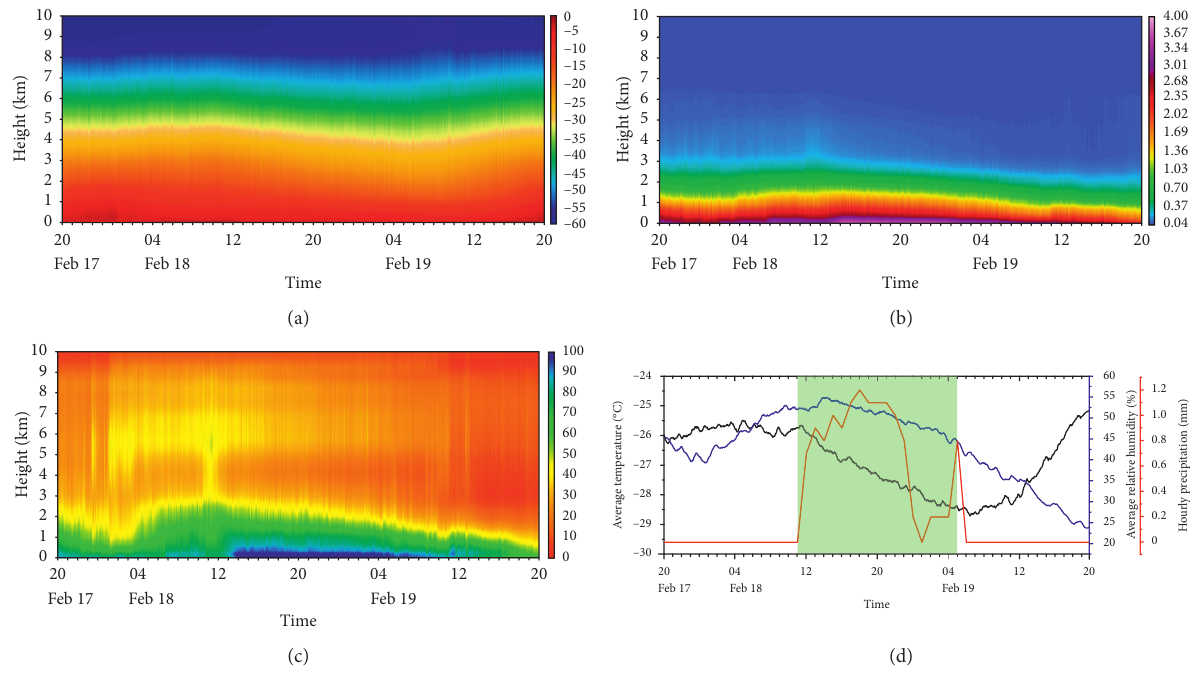
Figure 7: Time-height profile of ground-based microwave radiometer data: (a) temperature (shaded; unit, ° C), (b) water vapor density (shaded; unit, g kg − 1 ), (c) relative humidity (shaded; unit, %), and (d) average temperature, average relative humidity of the entire at- mosphere, and hourly precipitation evolution.